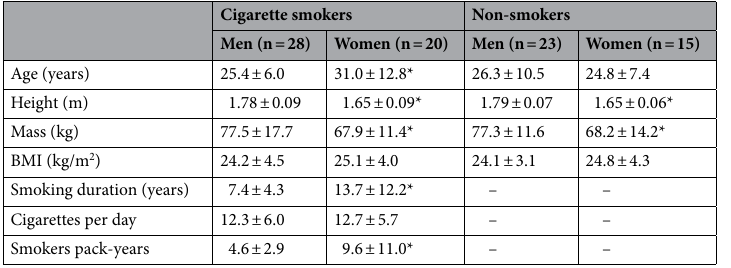
Table 1. Demographic data. All data are presented as mean ± SD; BMI: body mass index; *: significantly different from men at p <